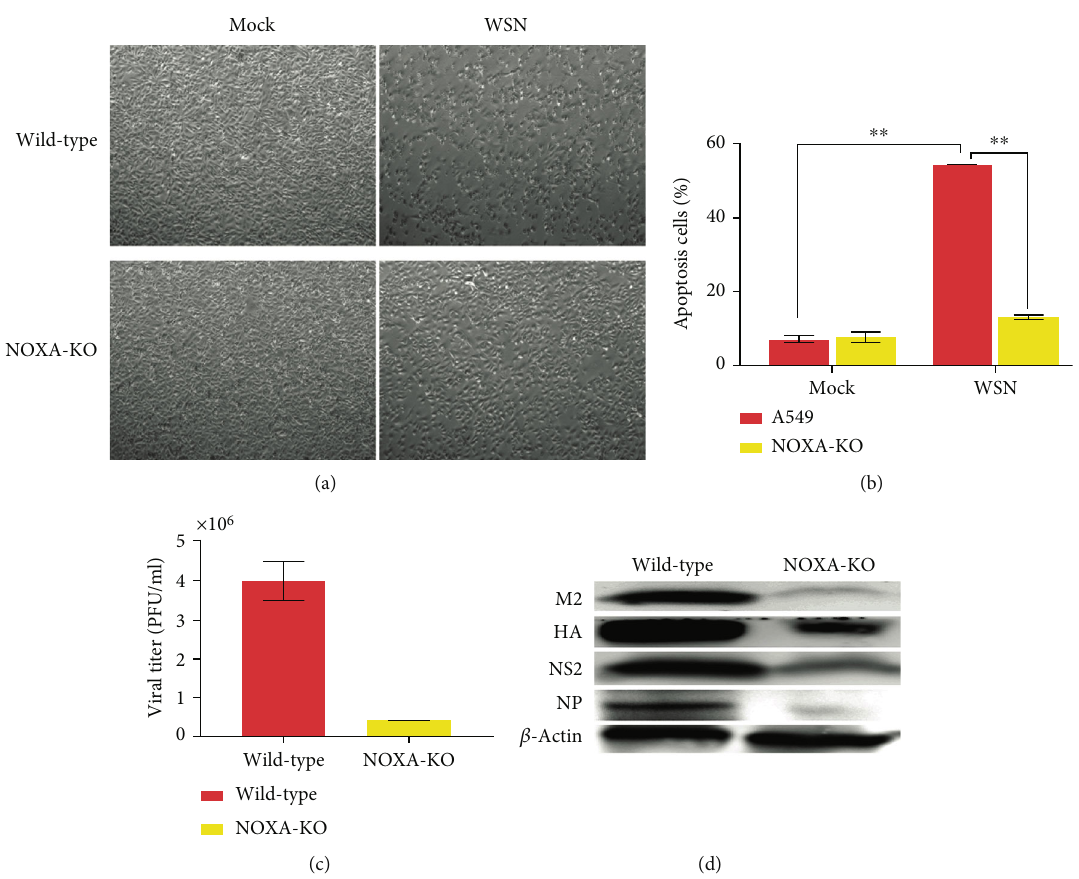
Figure 2: Noxa knockout inhibits in fl uenza virus replication. (a) Microscopy observations of virus-induced cytopathic e ff ect reduction in Noxa-knockout cells 24 h postinfection. Phase contrast microscopy was used to observe and photograph cells. Scale bar, 100 μ m. (b) Flow cytometry showed the apoptotic cell death in Noxa-knockout cells 24h postinfection. (c) Viral titer in the supernatant of the indicated cell lines was detected with a TCID50 assay 24h postinfection. (d) In fl uenza viral protein expression was analyzed via western blotting in Noxa-knockout cells 24h